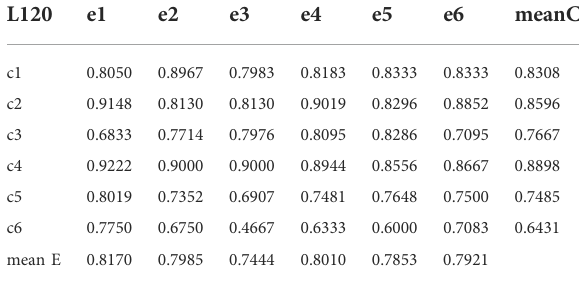
TABLE 5 The mean results of each multilayer network of the six crises in the 120-day window.